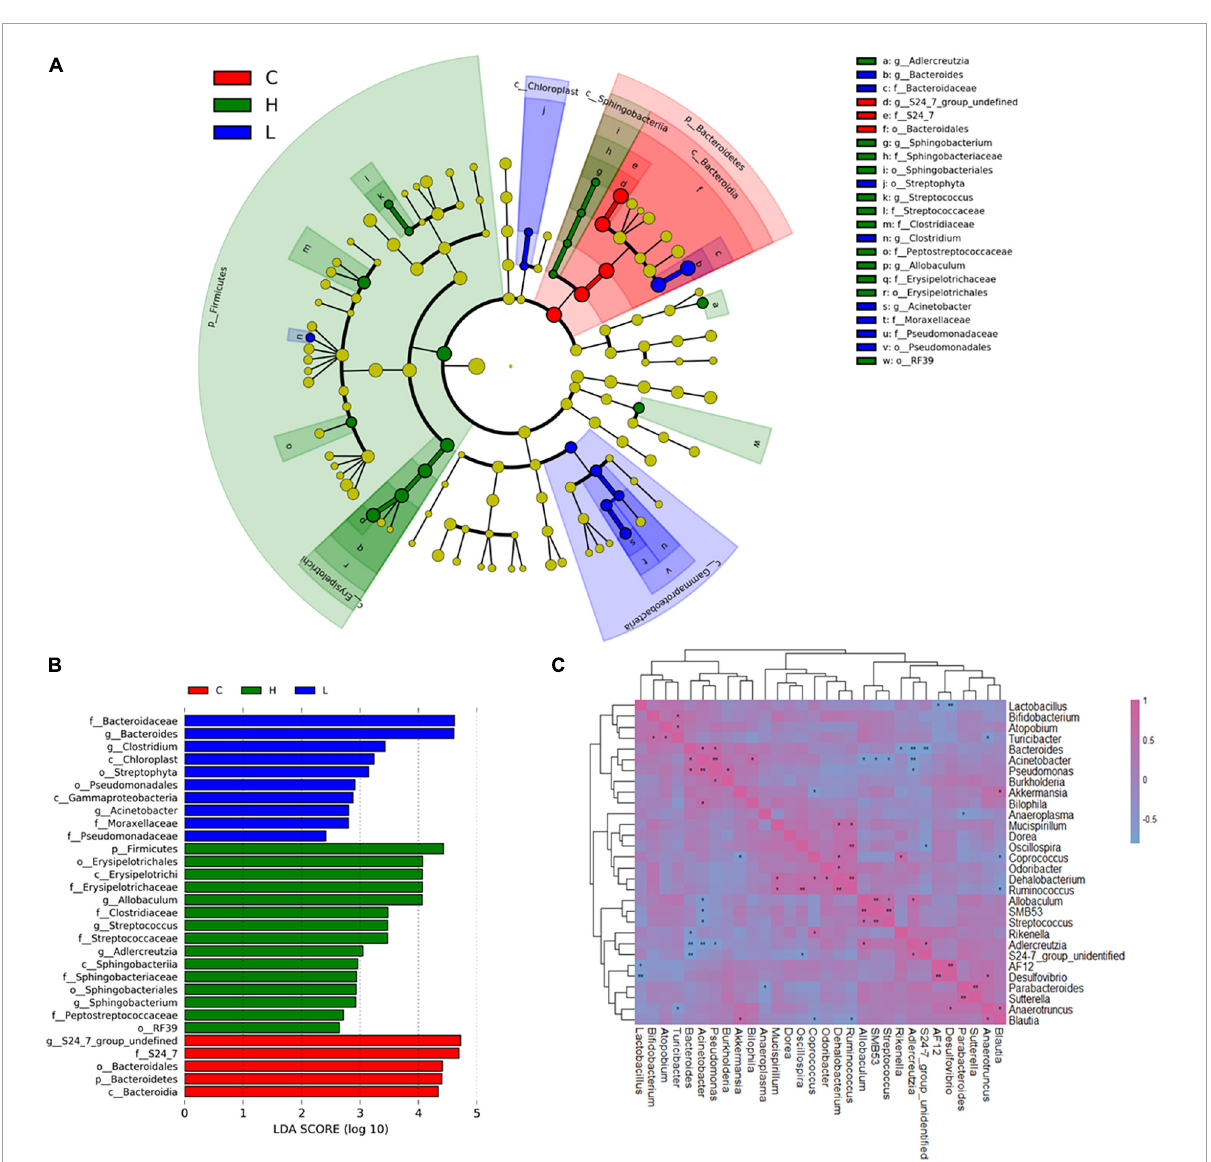
FIGURE4 Linear discriminant analysis (LDA) effect size (LEfSe) and correlation analysis of bacterial communities based on 16S rRNA gene sequences. (A) Taxonomic distribution of bacterial groups significant for inflammation and CRC. (B) Histogram of the LDA scores computed for differentially abundant bacterial taxa between health, inflammation and CRC. (C) Correlation analysis of the 30 most abundant genera in Group C, Group L, and Group H. *0.01 < p ≤ 0.05; ** p ≤